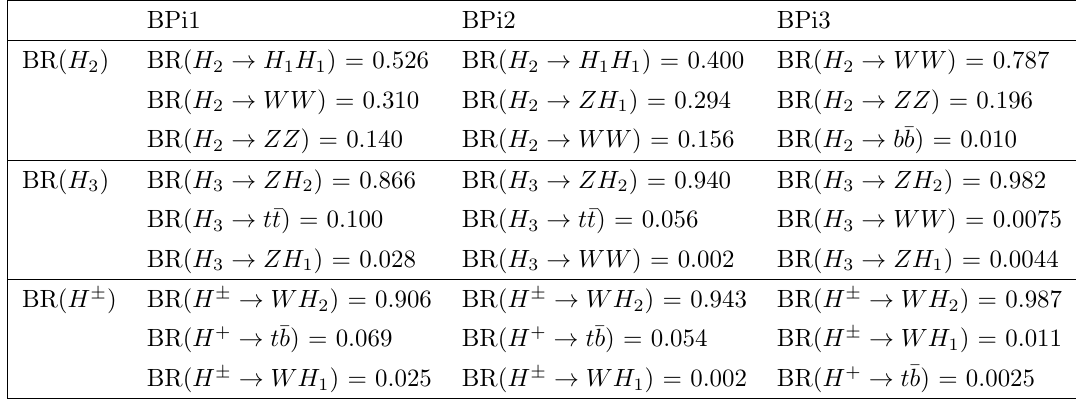
Table 3 . The dominant branching ratios of the BPi1-3 Higgs